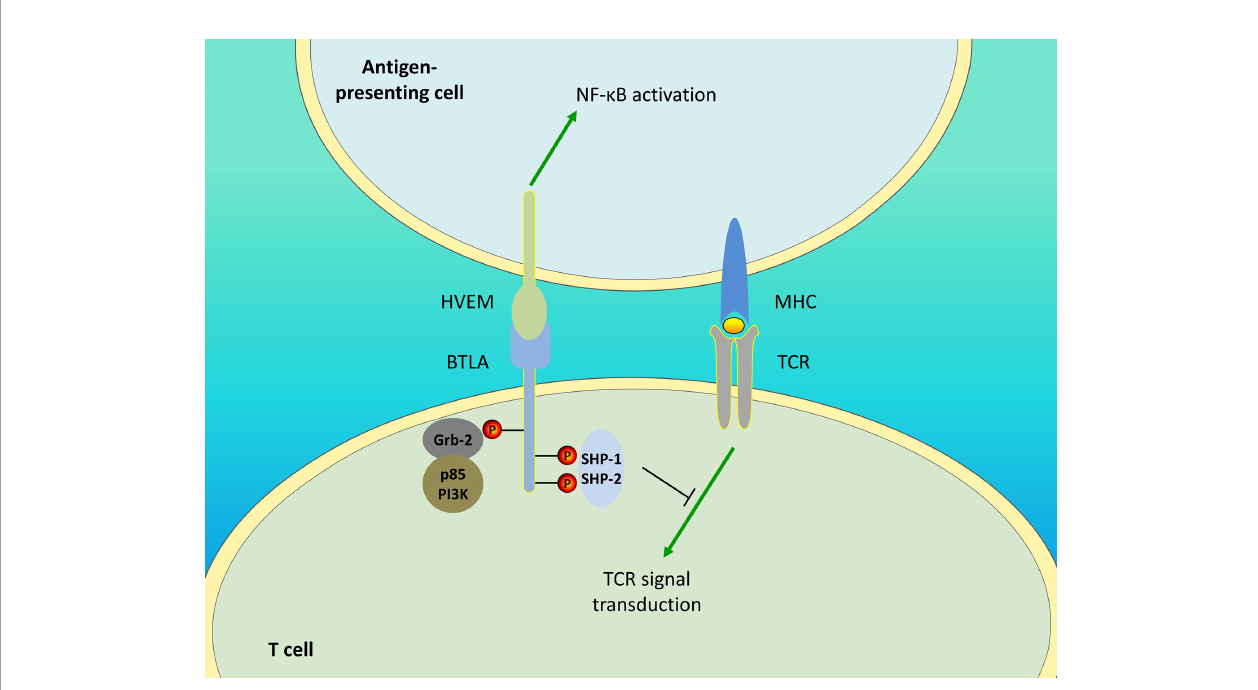
FIGURE 1 | Bidirectional signaling between BTLA and HVEM. Engagement of BTLA leads to SHP-1 and SHP-2 recruitment in T cells, thereby downregulating TCR signaling and delivering inhibitory signals. The Grb-2 association motif binds to Grb-2, leading to the recruitment of PI3K protein subunit p85 and the stimulation of the PI3K signaling pathway. Additionally, BTLA/HVEM signaling is bidirectional. BTLA/HVEM engagement induces HVEM-mediated NF- k B activation in antigen- presenting cells, thus providing proin fl ammatory and pro-survival